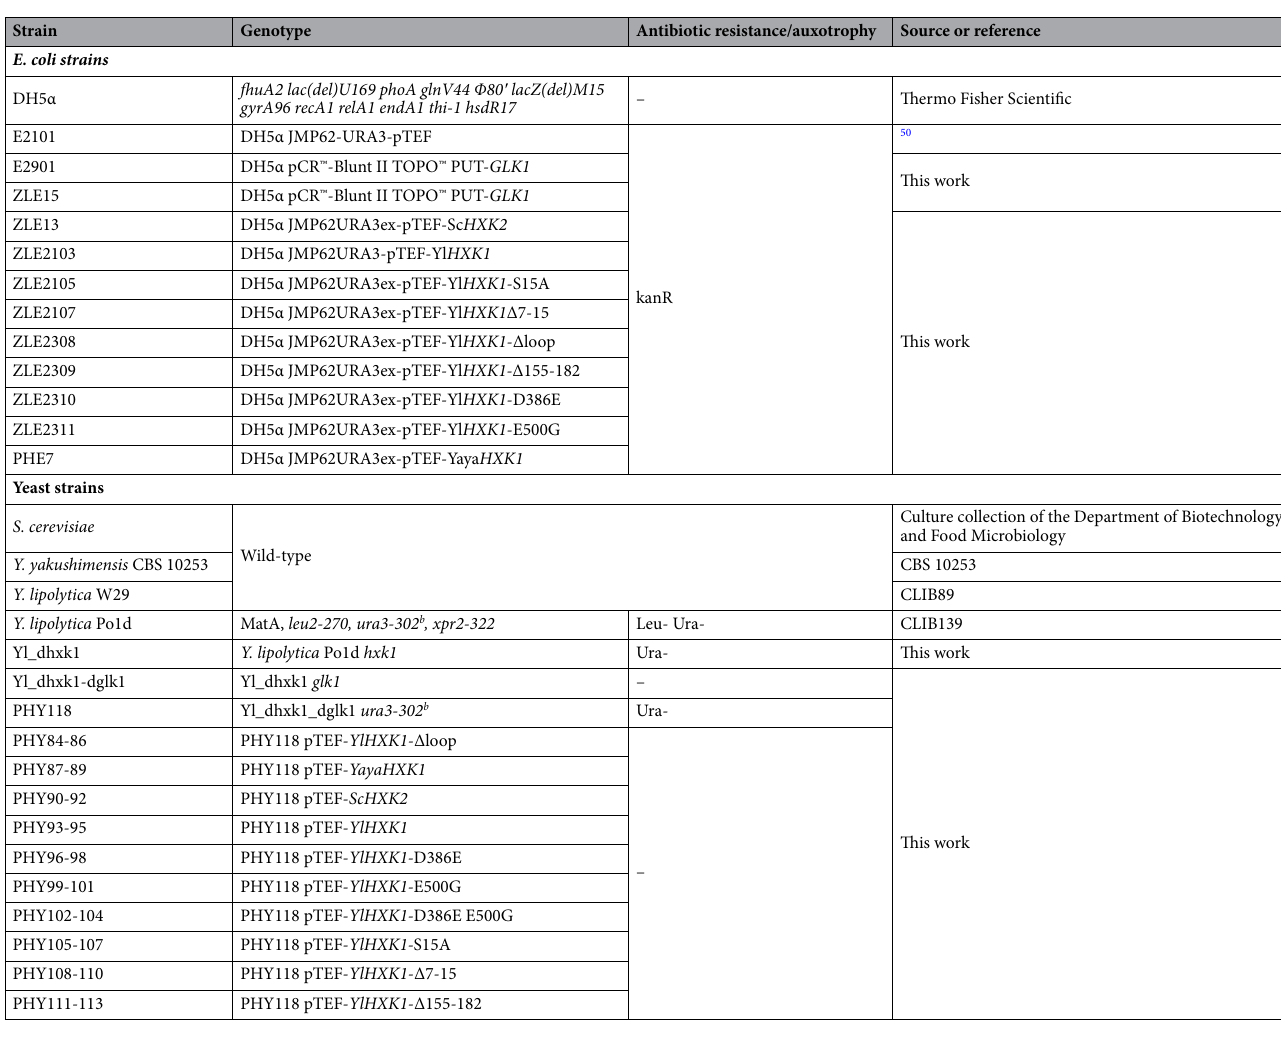
Table 1. Strains used in this